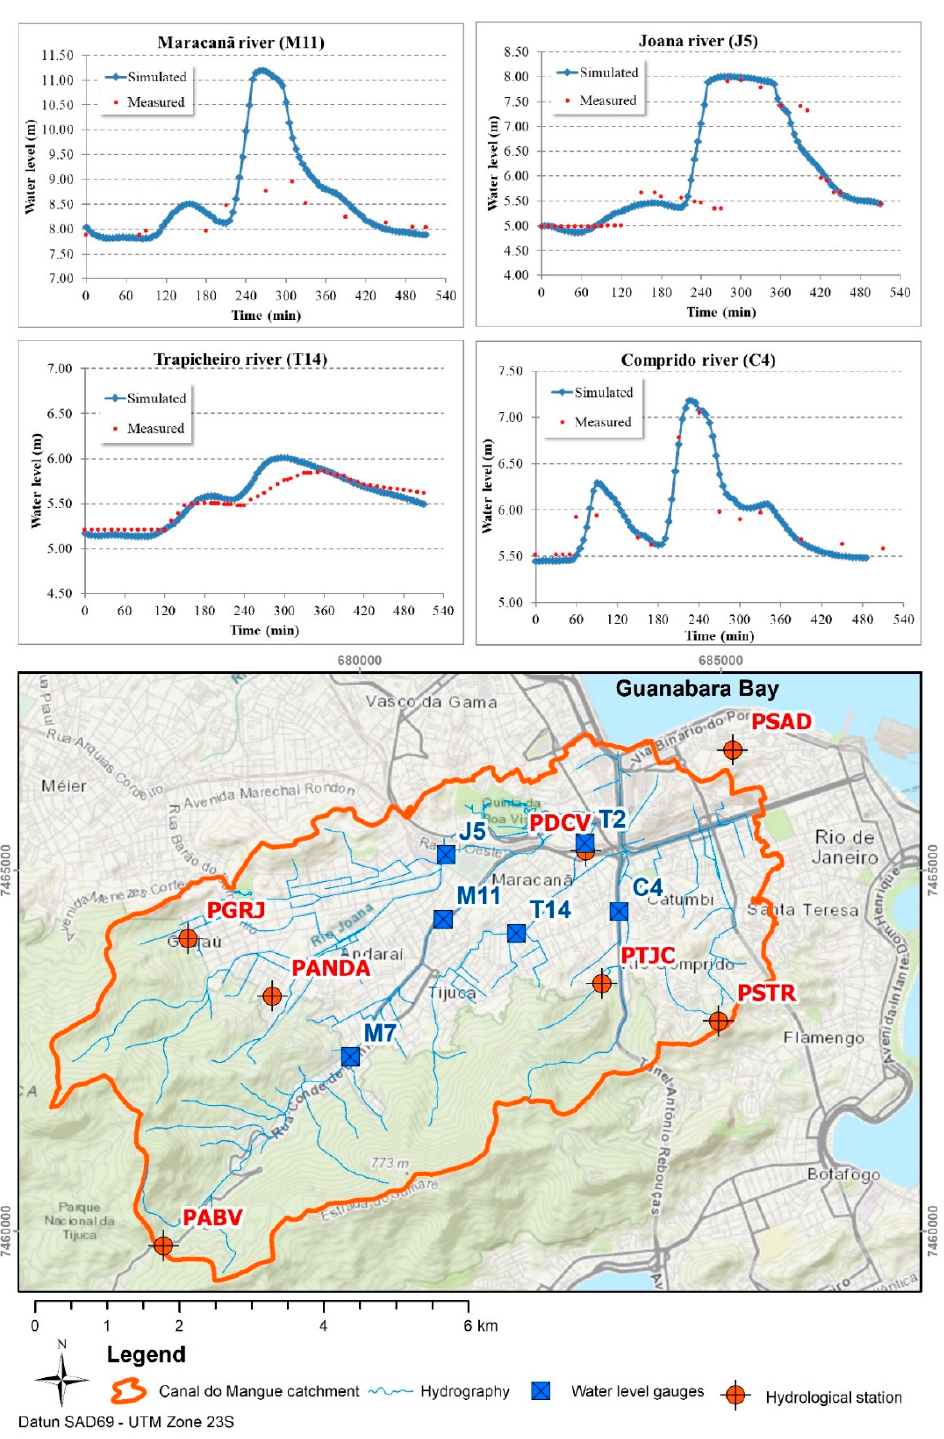
Figure 8. Localization of measuring stations and water level results of the calibration